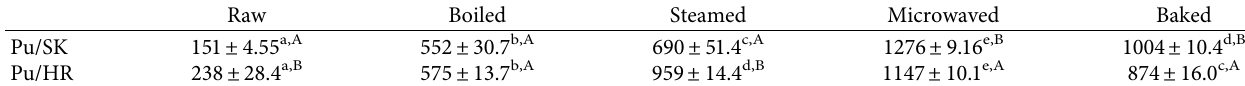
Table 4: Total anthocyanins content (mg CyE/kg